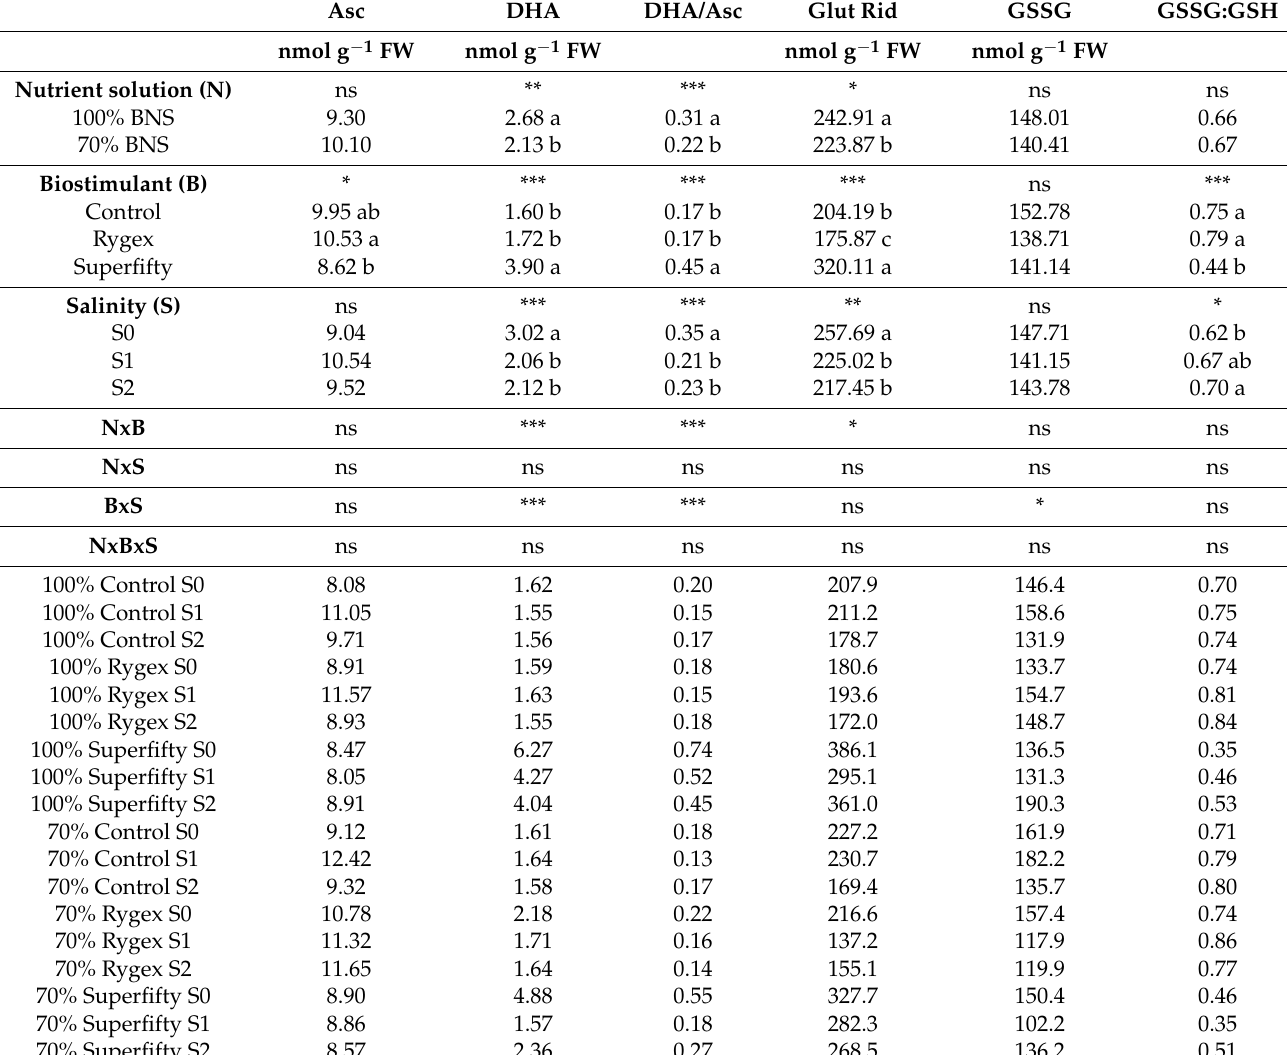
Table 3. Significance of the main factors (nutrient solution, biostimulant and salinity) and their interactions on content of ascorbate (Asc), Dehydroascorbate (DHA), DHA:Asc, reduced glutathione (GSH), oxidized glutathione (GSSG) and GSSG:GSH in leaves of MicroTom plants. Experimental design is as in Table